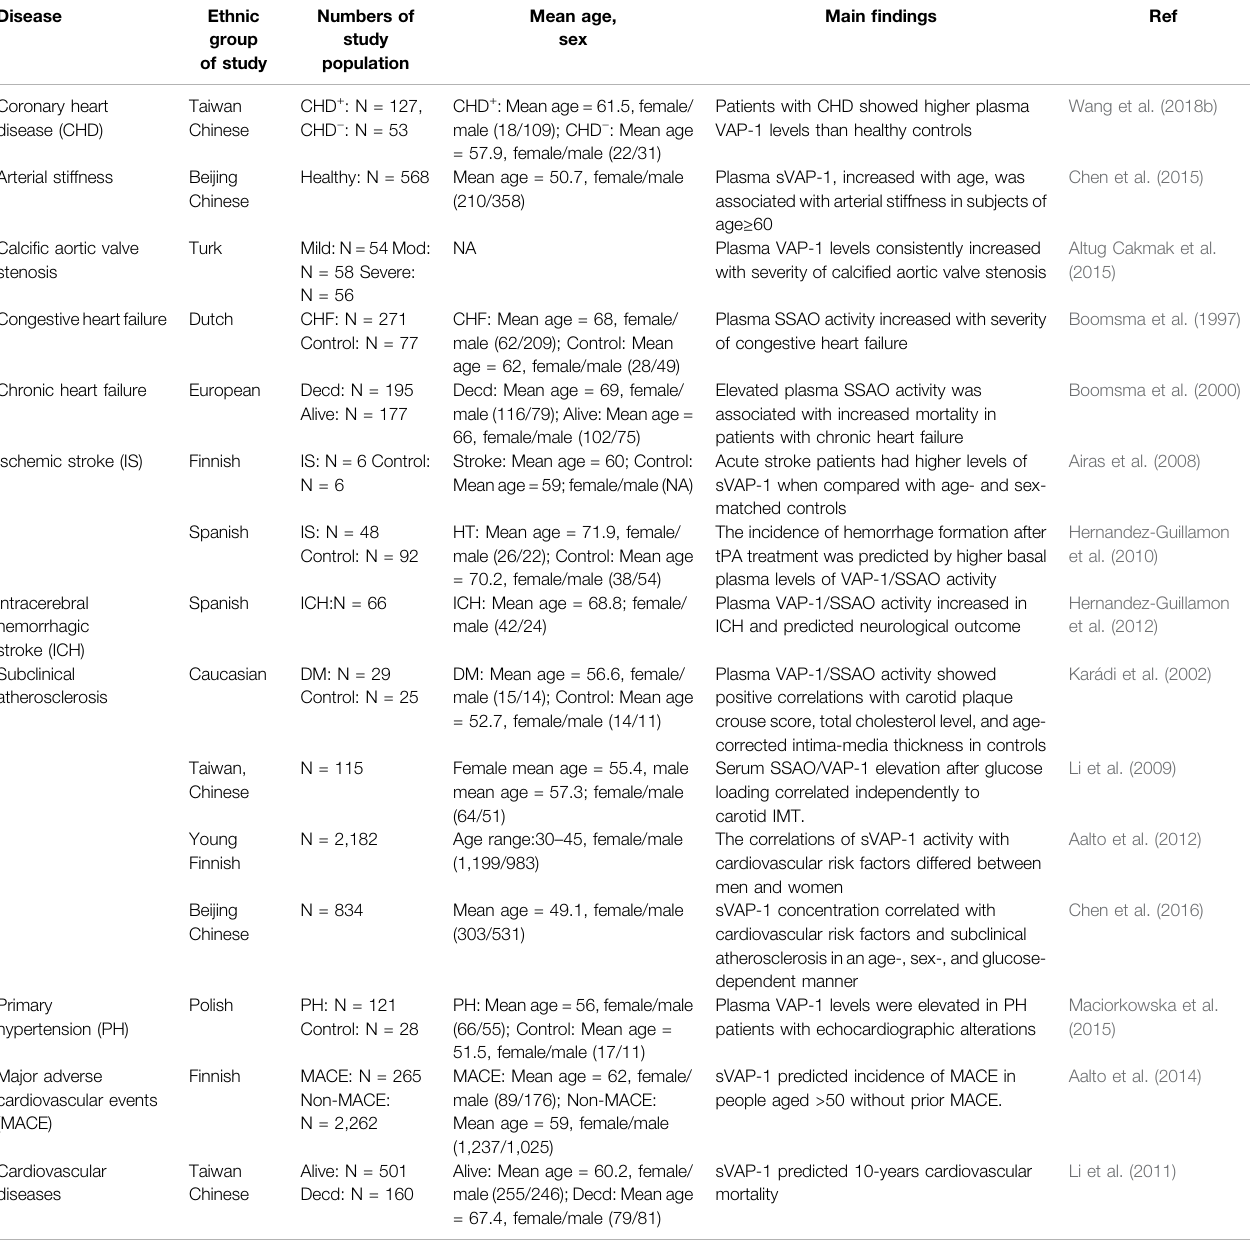
TABLE 1 | sVAP-1 in human cardiovascular diseases. Disease Ethnic